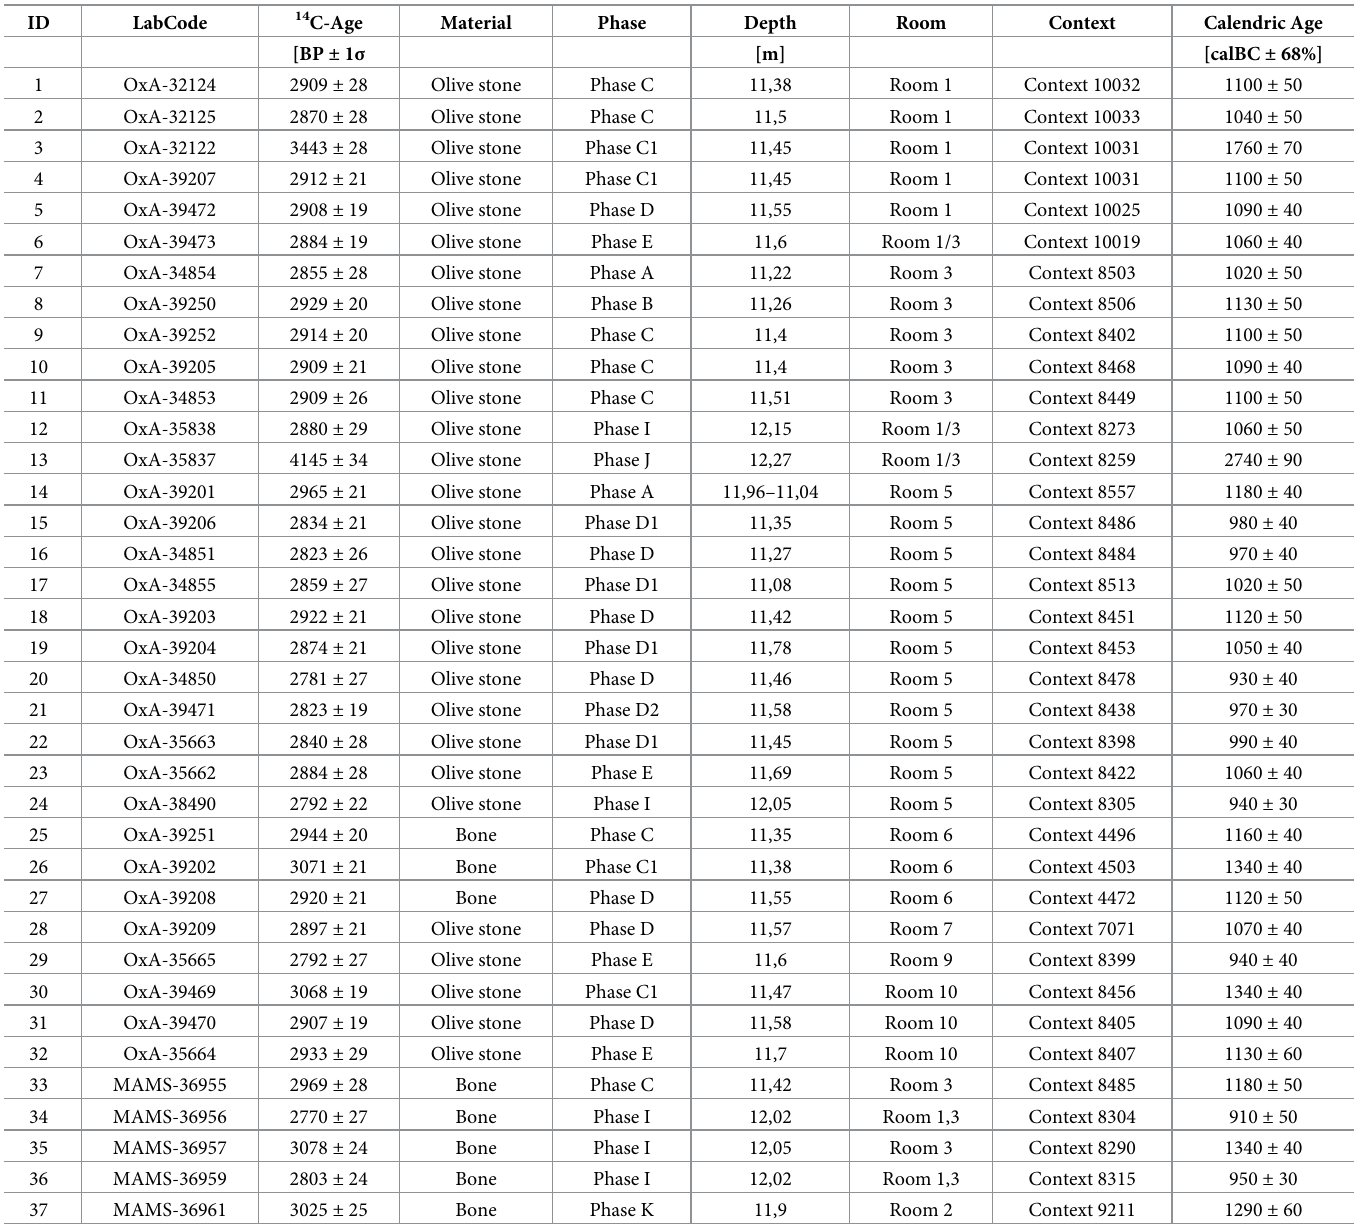
Table 1. Sidon radiocarbon ages (N =